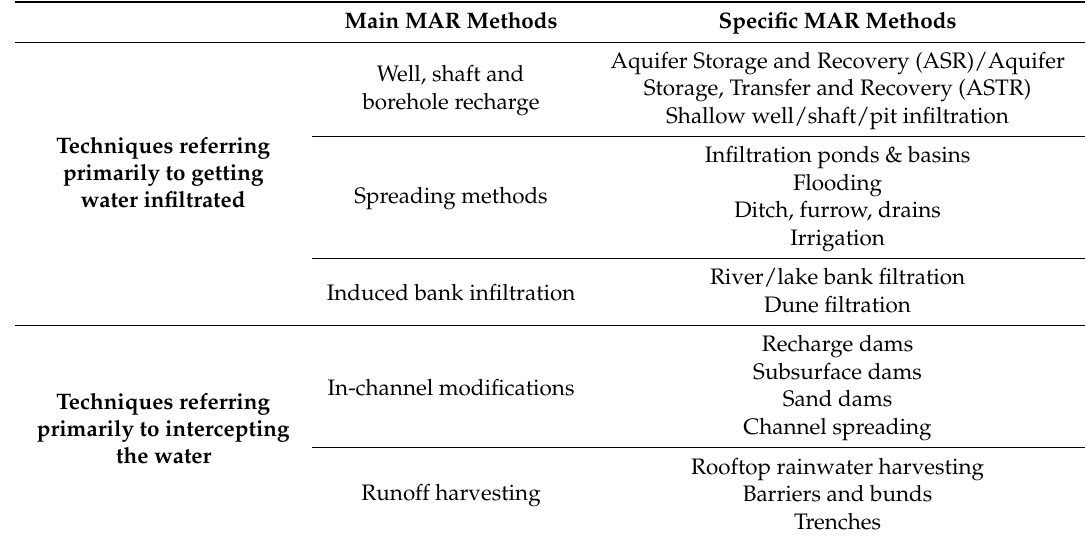
Table 1. Managed Aquifer Recharge (MAR) classification system stating five main methods and associated specific MAR methods, adapted from International Groundwater Resources Assessment Centre